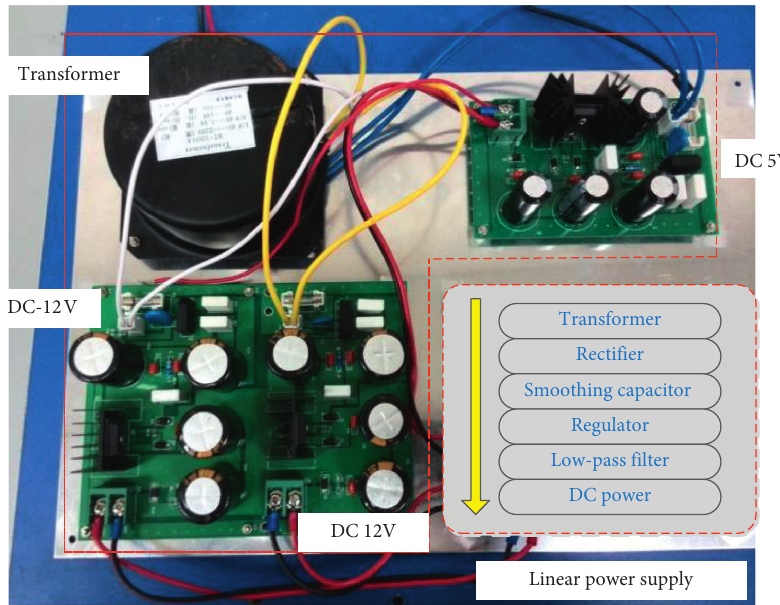
Figure 6: Photo of the self-developed linear power